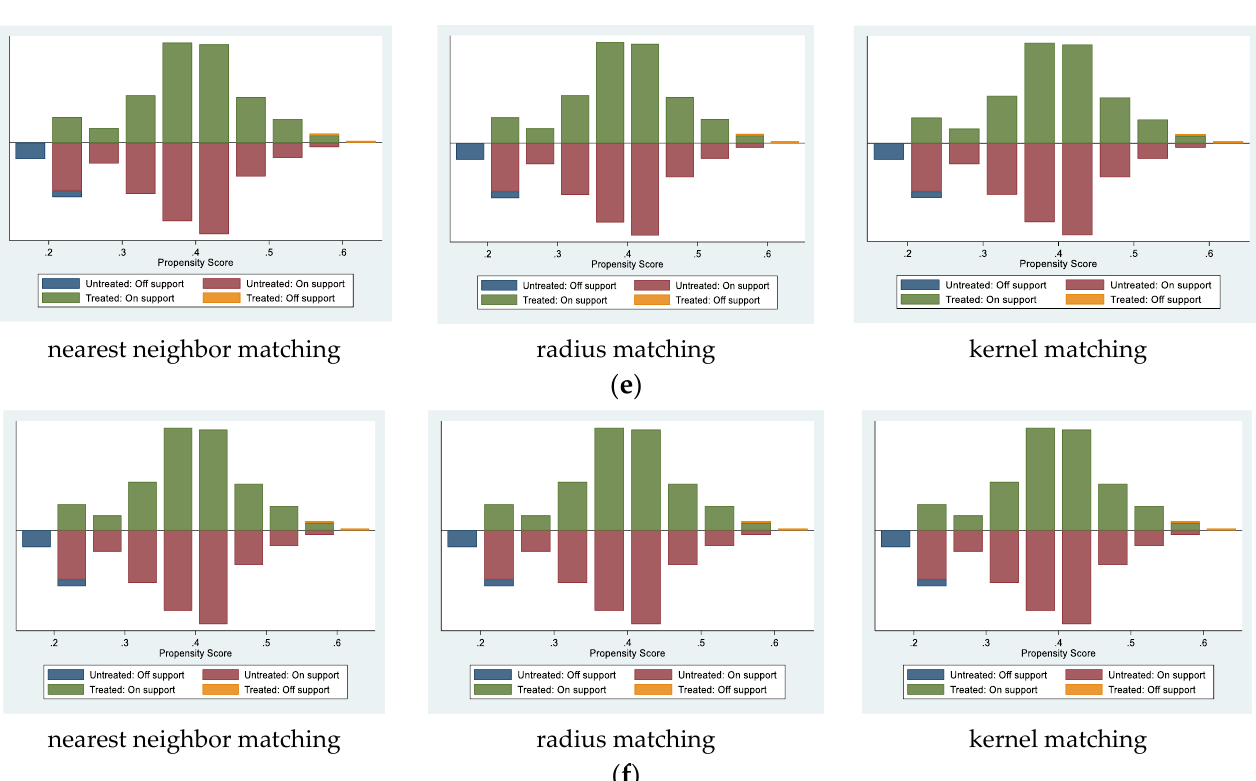
Figure 3. Propensity score distribution and the common support for propensity score estimation. ( a ) farmland transfer-out and farmland not transfer-out, CS = total consumption of rural households. ( b ) farmland transfer-out and farmland not transfer-out, CS = food consumption. ( c ) farmland transfer-out and farmland not transfer-out, CS = non-food consumption. ( d ) farmland transfer-in and farmland not transfer-in, CS = total consumption of rural households. ( e ) farmland transfer-in and farmland not transfer-in, CS = food consumption. ( f ) farmland transfer-in and farmland not transfer-in, CS = non-food